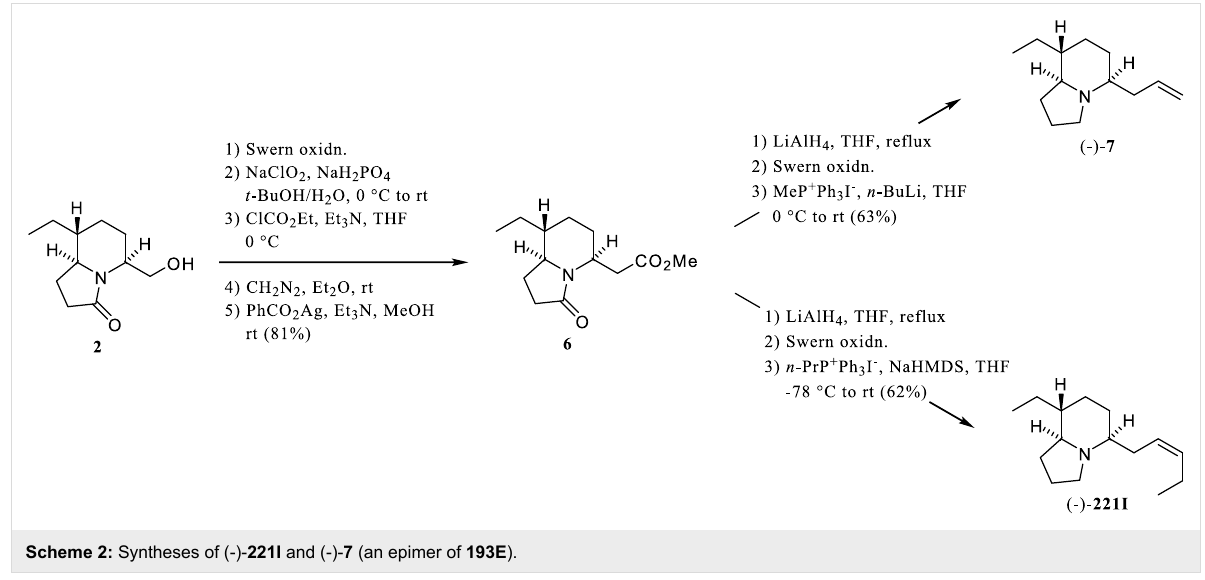
was greatly decreased, whereas the responses elicited in oocytes CI: 18.5 to 28.9 μM) (Figure 2). Synthetic (-)-epi- 193E was more potent in blocking the α7 receptor response (IC 50 = 9.1 μM, 95% CI: 7.5 to 11.1 μM) compared to blockade of the α4β2 receptor (IC 50 = 18.0 μM, 95% CI: 12.2 to 26.7 μM) (Figure